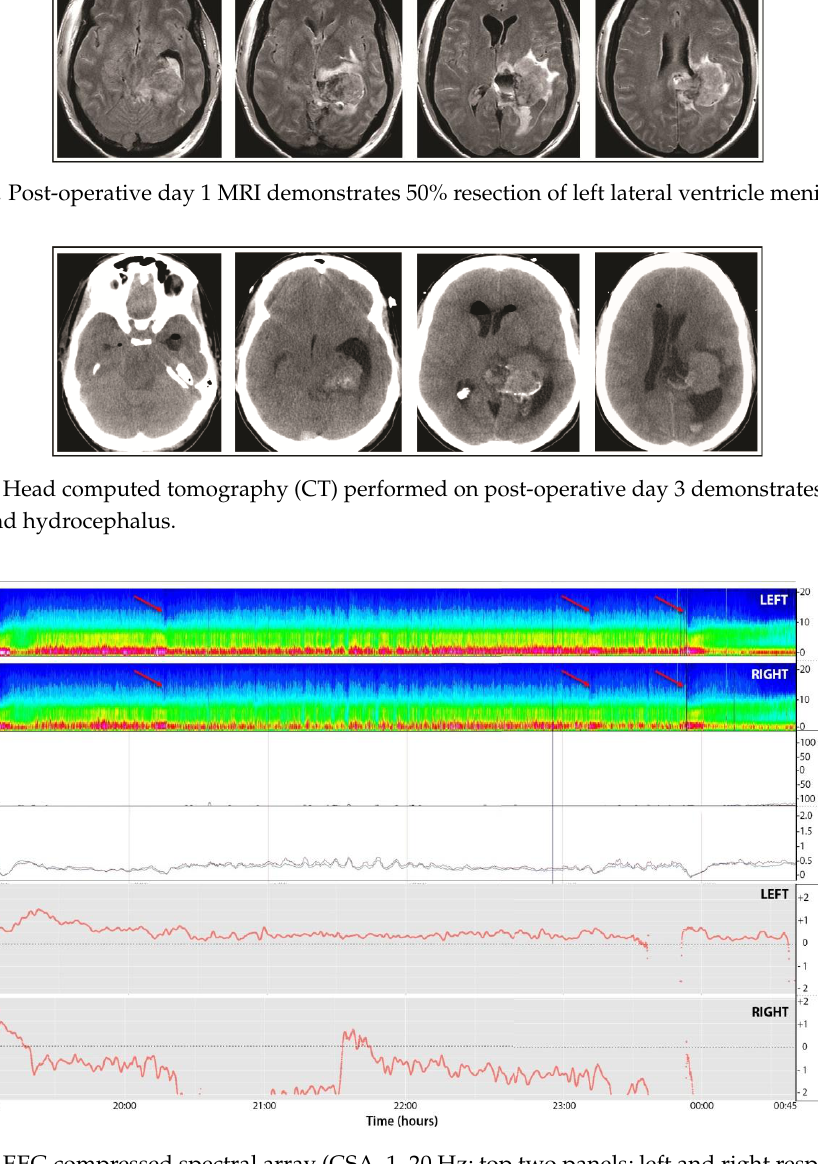
Figure 4. EEG compressed spectral array (CSA, 1–20 Hz; top two panels; left and right respectively), suppression ratio (Supp%), alpha-delta ratio (ADR; 8–14/1–4 Hz; 2 min moving average), and cerebral flow indices (CFI; bottom two panels, left and right, respectively) over an 8 h window. CFI are z -normalized to the mean for the entire time series, represented by dashed line. The red arrows denote periods in which the patient clinically experienced a depressed level of consciousness, pupillary dilatation, and dysautonomia. These periods correlate to attenuation of faster frequencies and small decreases in CFI. CSA: Compressed spectral array; CFI: Cerebral flow indices; Supp: Suppression; FFT: Fast Fourier Transform; ADR:Alpha delta ratio